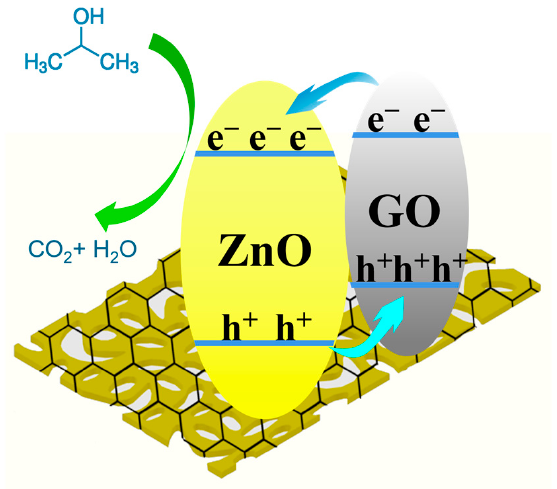
Figure 13. Sensing mechanism of the GO/ZnO nanosheet composites.